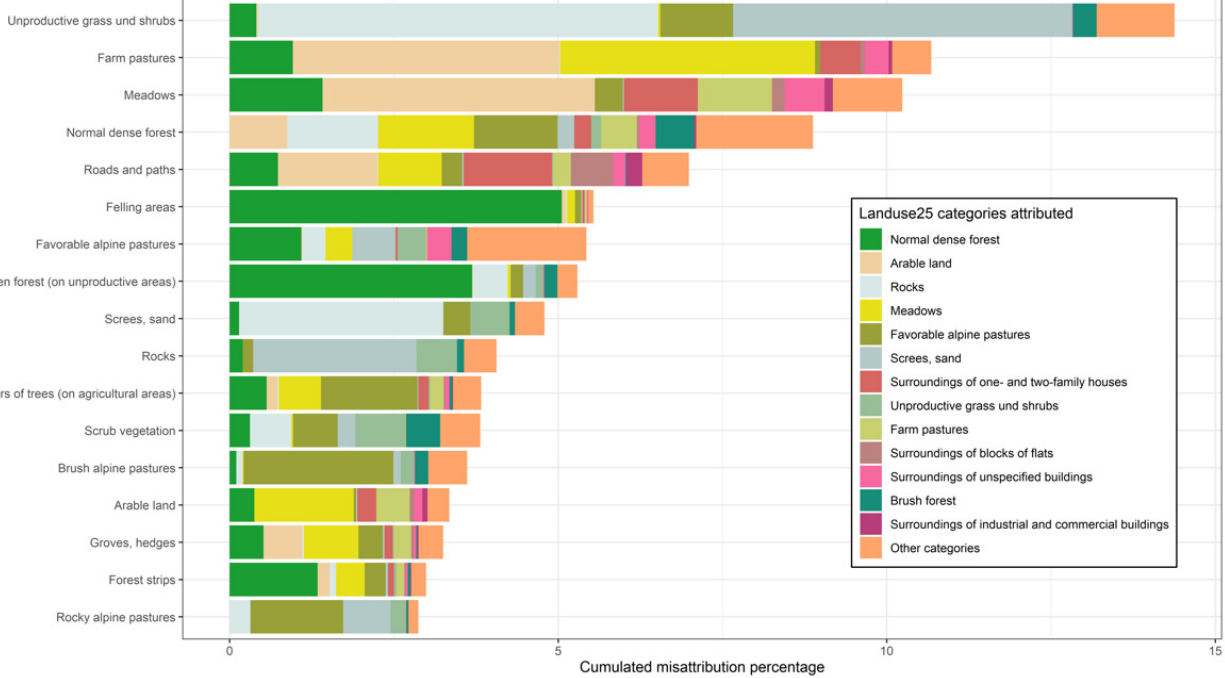
Figure 8. Percentage of all misclassifications for the 17 main classes of the 2018 downscaled LU without linear features. Legend lists categories that were misattributed.